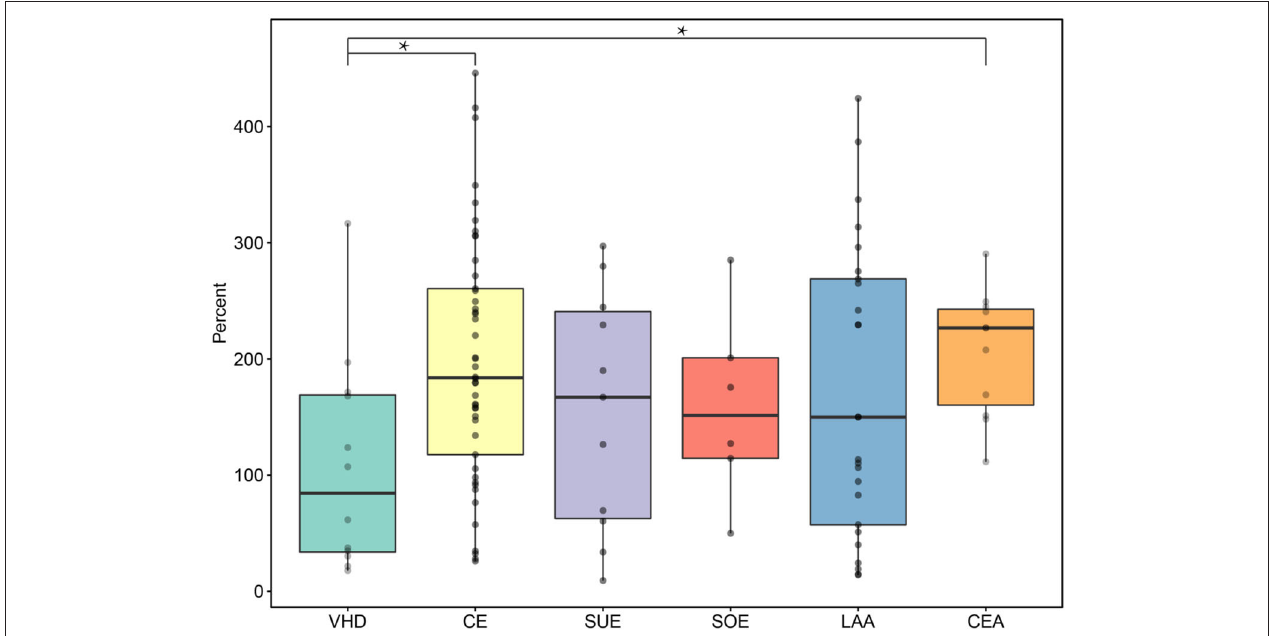
FIGURE 3 | WBC counts of VHD, CEA, and subtypes of TOAST. VHD, valvular heart disease; CE, cardioembolic; SUE, stroke of undetermined etiology; SOE, stroke of other determined etiology; LAA, large artery atherosclerosis; CEA, carotid endarterectomy. * P <